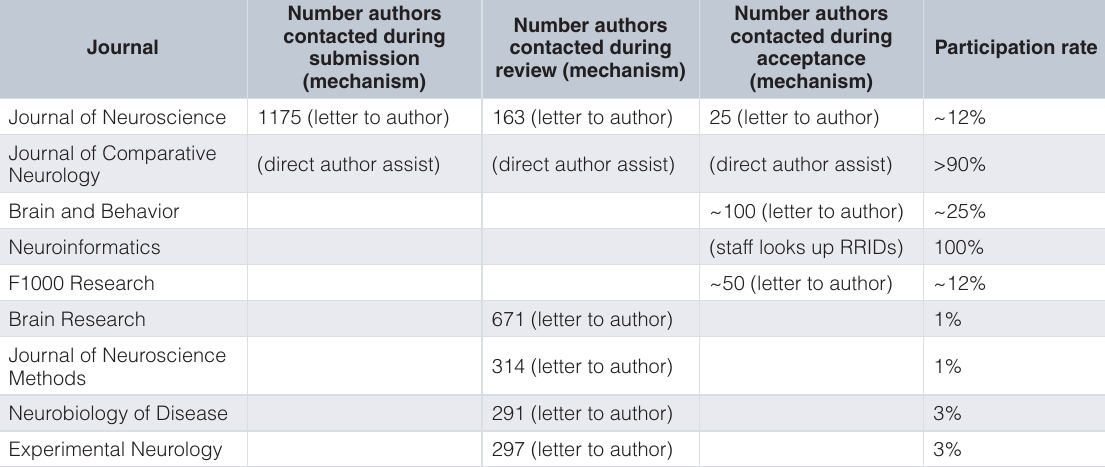
Table 2. Journal practices in contacting authors. Different journals chose to contact authors at different stages of the publishing cycle and assist in the addition of RRIDs via different mechanisms. The participation rate was by far the lowest with only instructions to authors; these journals are not included in this table (for example BMC) and had <1% participation rates. When authors were asked by a blanket mailing containing instructions, participation rates ranged between 1 and 15%. Participation was very high if the editorial staff asked authors directly or suggested identifiers for their manuscript. Note that in some cases only an approximation could be made by the participating